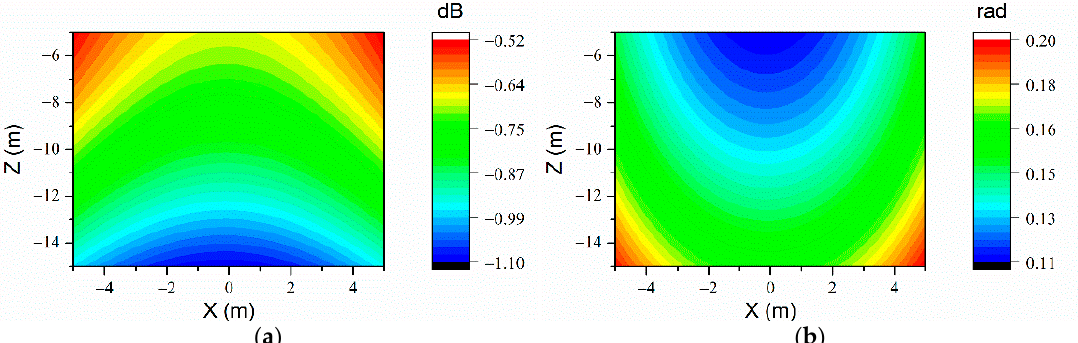
Figure 5. The sound prediction errors of ESM on the prediction plane in the free field at the frequency of 71 Hz (270uniform arranged measurement points determined by SVM). ( a ) p E and ( b ) ϕ E .